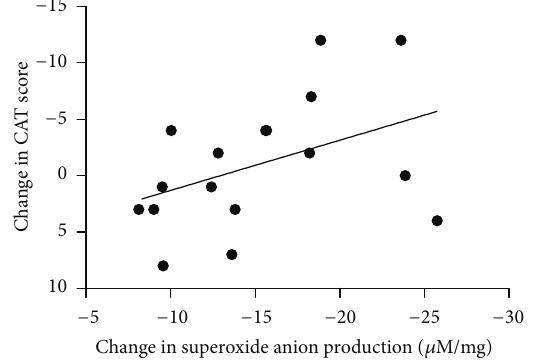
Figure 5: Correlation between changes in COPD Assessment Test (CAT) questionnaire score and superoxide anion production in exhaled breath condensate of COPD treated with sulphurous thermal water at one month after the end of the inhalatory treatment compared to